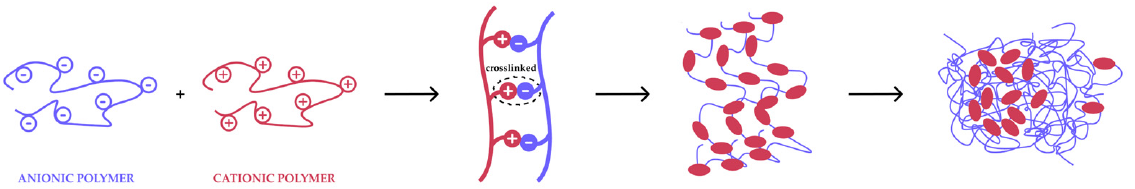
Figure 8. Formation of polyelectrolyte complexes (PECs) through electrostatic complex coacerva- tion.